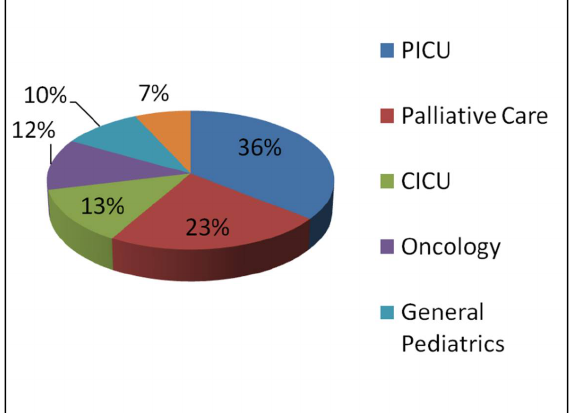
Figure 2. Location of death for patients with a DNR order in place.